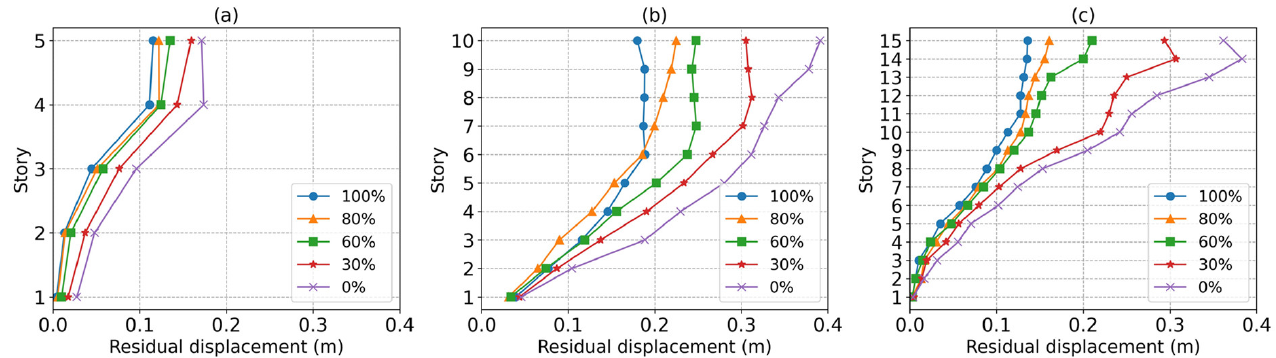
Figure 18. Residual displacement: ( a ) 5-story frames; ( b ) 10-story frames; and ( c ) 15-story frames.